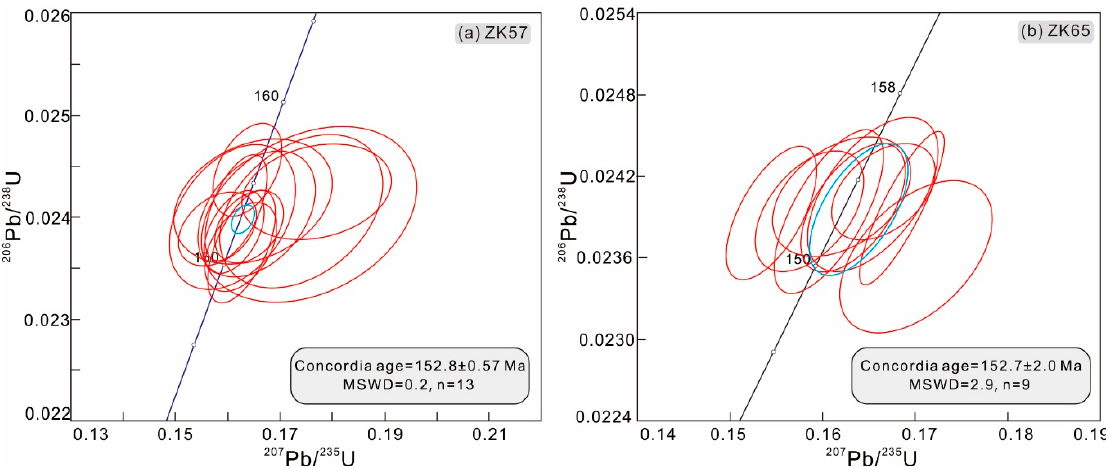
Figure 9. LA – CP – MS zircon U – Pb Concordia diagrams for the drill cores of ZK57 ( a ) and ZK65 ( b ) from the Xinfeng mine, Xianghualing area, South China.